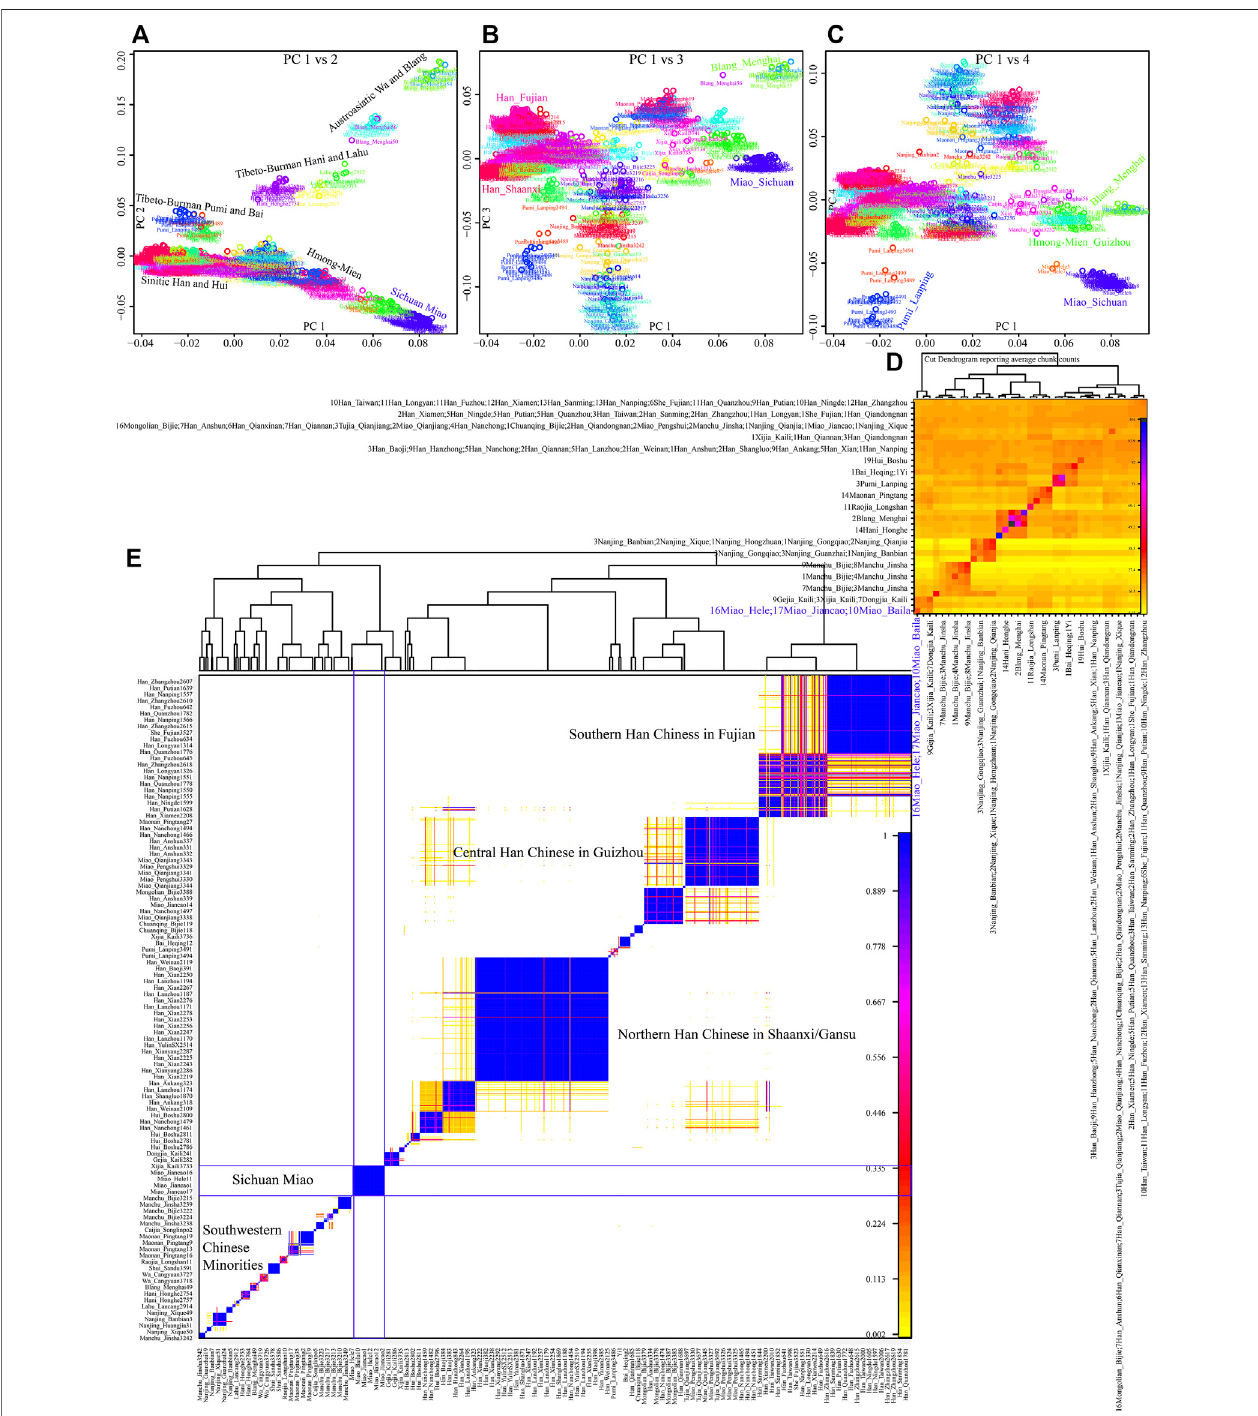
FIGURE 3 | Fine-scale population genetic structure based on the shared haplotype data. (A – C) PCA results based on the coancestry matrix showed a genetic relationship among modern East Asians. The color showed the re-classi fi cation of the homogenous population label. (D,E) Clustering patterns of individual-level and population-level East Asians based on the pairwise coincidence